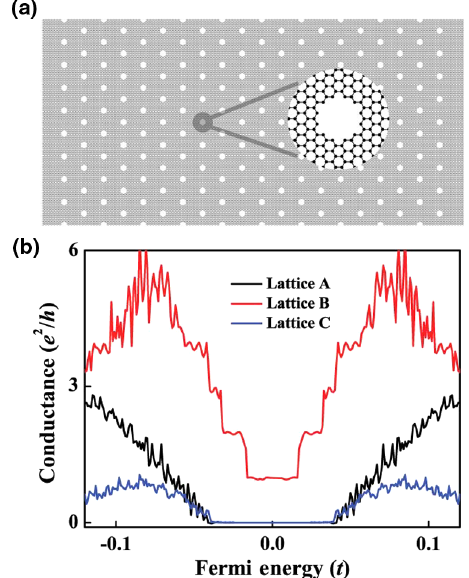
FIG. 4. (a) Schematic illustration of an antidot graphene lattice (Lattice B) for calculating the conductance as a function of Fermi energy. The system contains 20 holes in the x direction and 10 holes in the y direction. The inset is a zoom-in image of the antidot latticewith ahole. (b)Calculated conductance plotted asa function of Fermi energy. The black curve represents the conductance of Lattice A, where the zero-conductance plateau indicates the band gap of this system. For Lattice B, the red curve exhibits no zero- conductance regions, implying that there is no band gap. Lattice C differs from Lattice B only at the edges of the holes, wherewe have added atomic-scale randomness. Ten different randomness pro- files were calculated, and the blue curve represents the ensemble- averaged conductance. It is seen that a band gap reappears, and the magnitude of this band gap is the same as that of Lattice A, implying that the transport gap in Lattice C has the same origin as that in Lattice A, i.e., from K to K 0 intervalley